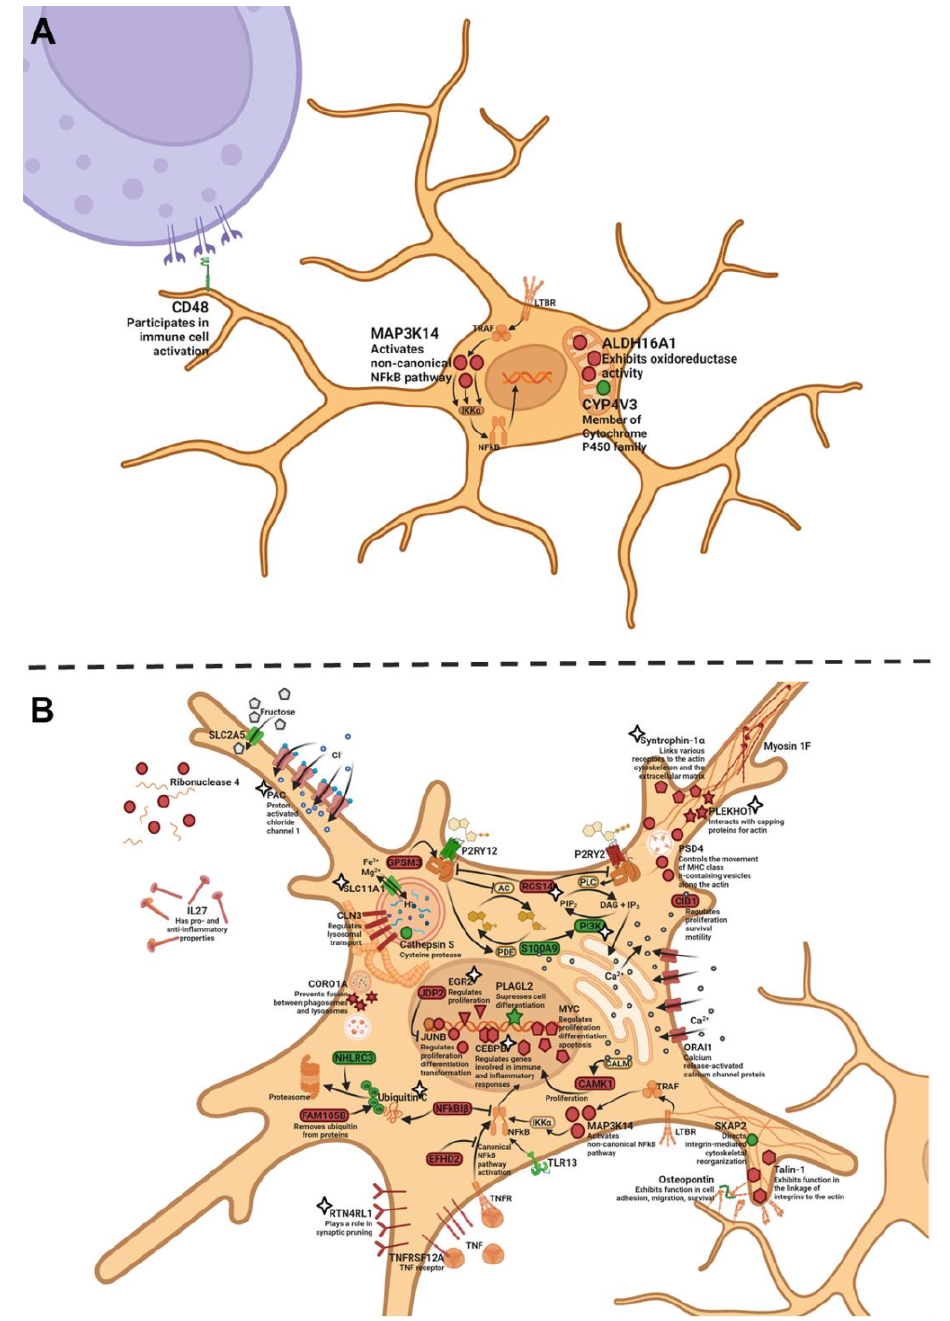
Figure 5. A microglial cell of 5-month-old ( A ) and 18-month-old ( B ) OXYS rats. Proteins with higher mRNA expression compared to Wistar rats or to previous age are highlighted in green; proteins with higher mRNA expression are red. Stars ( B ) indicate the genes whose expression was altered by SkQ1. The illustration was created on BioRender.com (accessed on 15 November